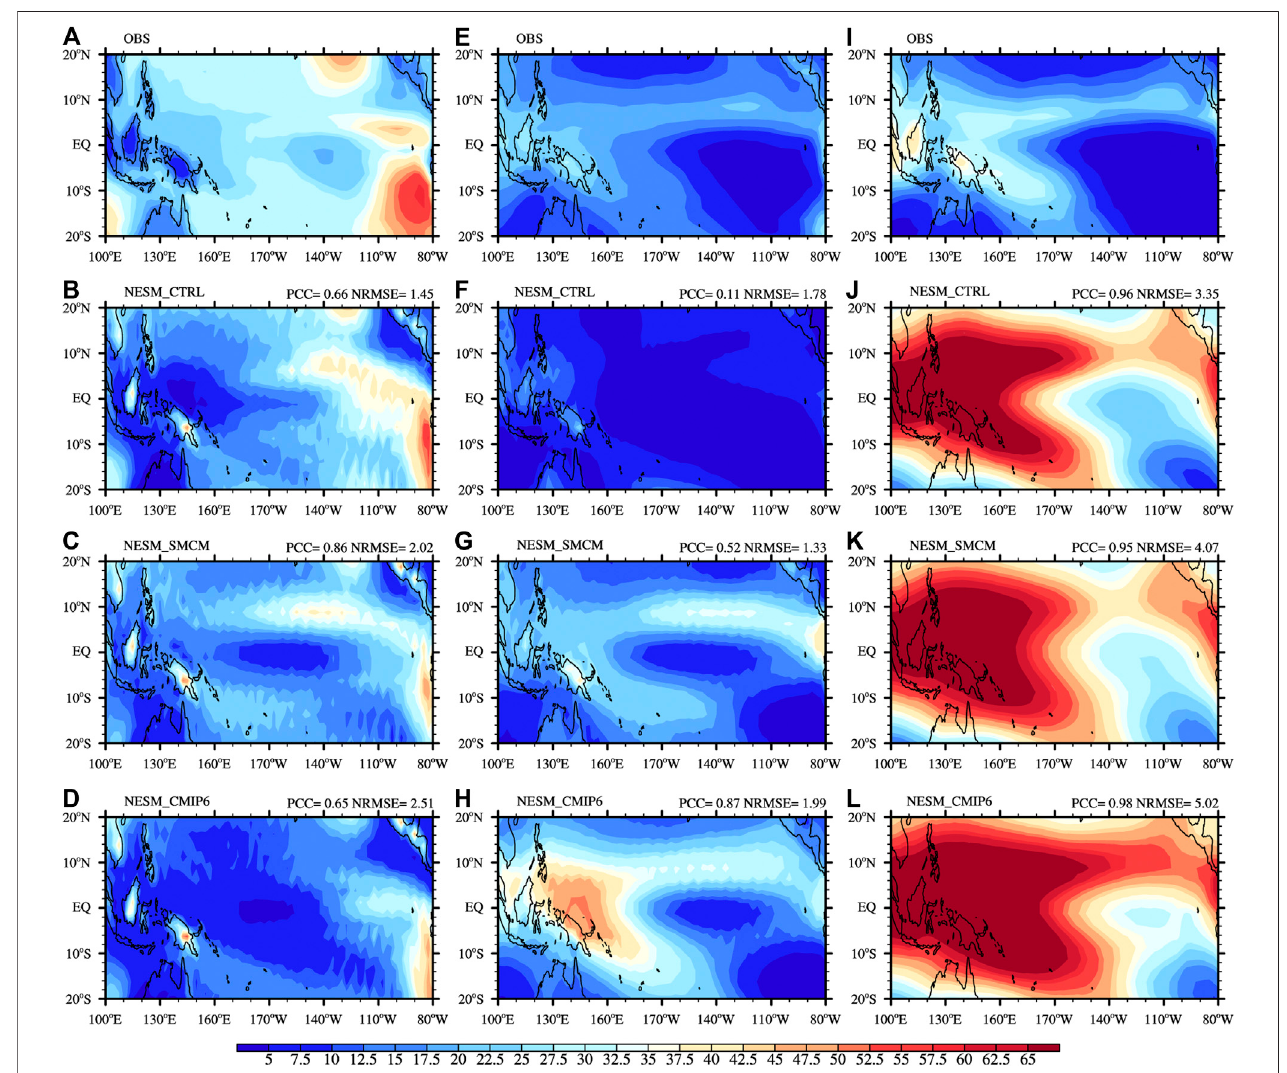
FIGURE1| Annual-mean low-level (left panel), middle-level (middlepanel),and high-levelcloud cover (unit%): (A,E,I) observations, (B,F , J) NESM_CTRL, (C,G,K) NESM_SMCM, and (D,H,L) NESM_CMIP6. The PCC and NRMSE scores were calculated over the tropical Paci fi c Ocean (20 ° S – 20 ° N, 100 – 280 ° E).